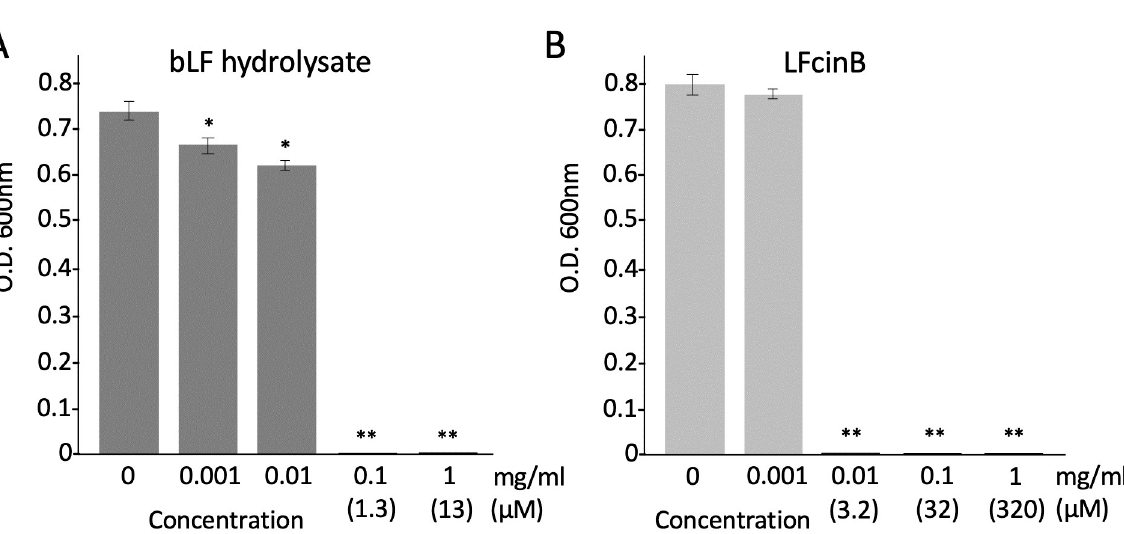
PLOS ONE | https://doi.org/10.1371/journal.pone.0264094 February 25,